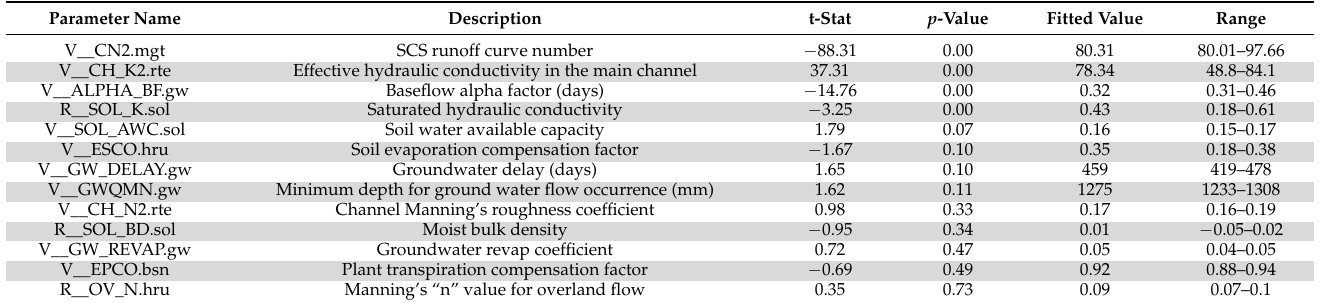
Table 4. SWAT model’s parameter sensitivity analysis results, best fitted value, and range.